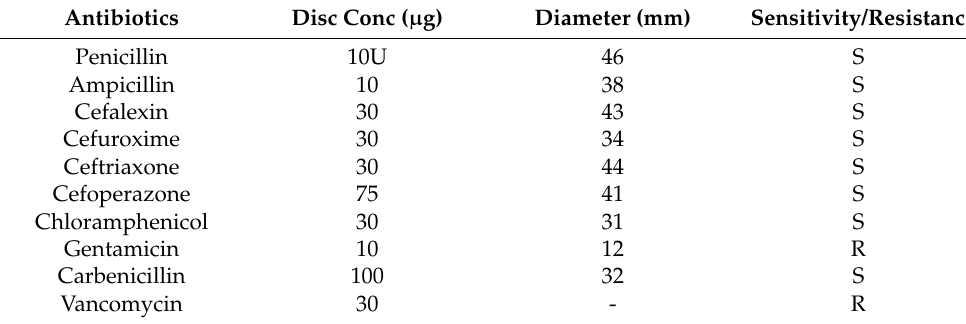
Table 2. Antibiotic sensitivity test of the strain YPG14.